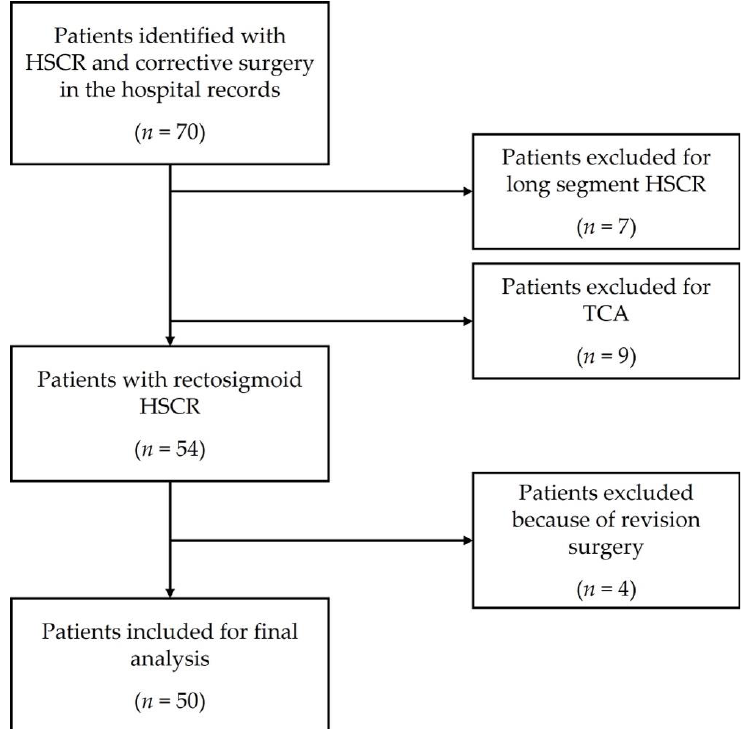
Figure 1. Patients included in the study.